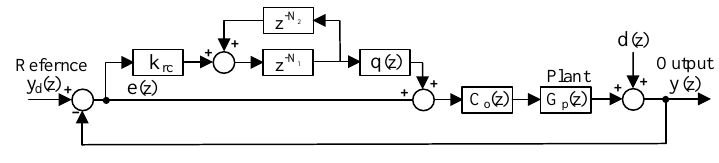
Figure 5. Control scheme for the AC/DC converter.